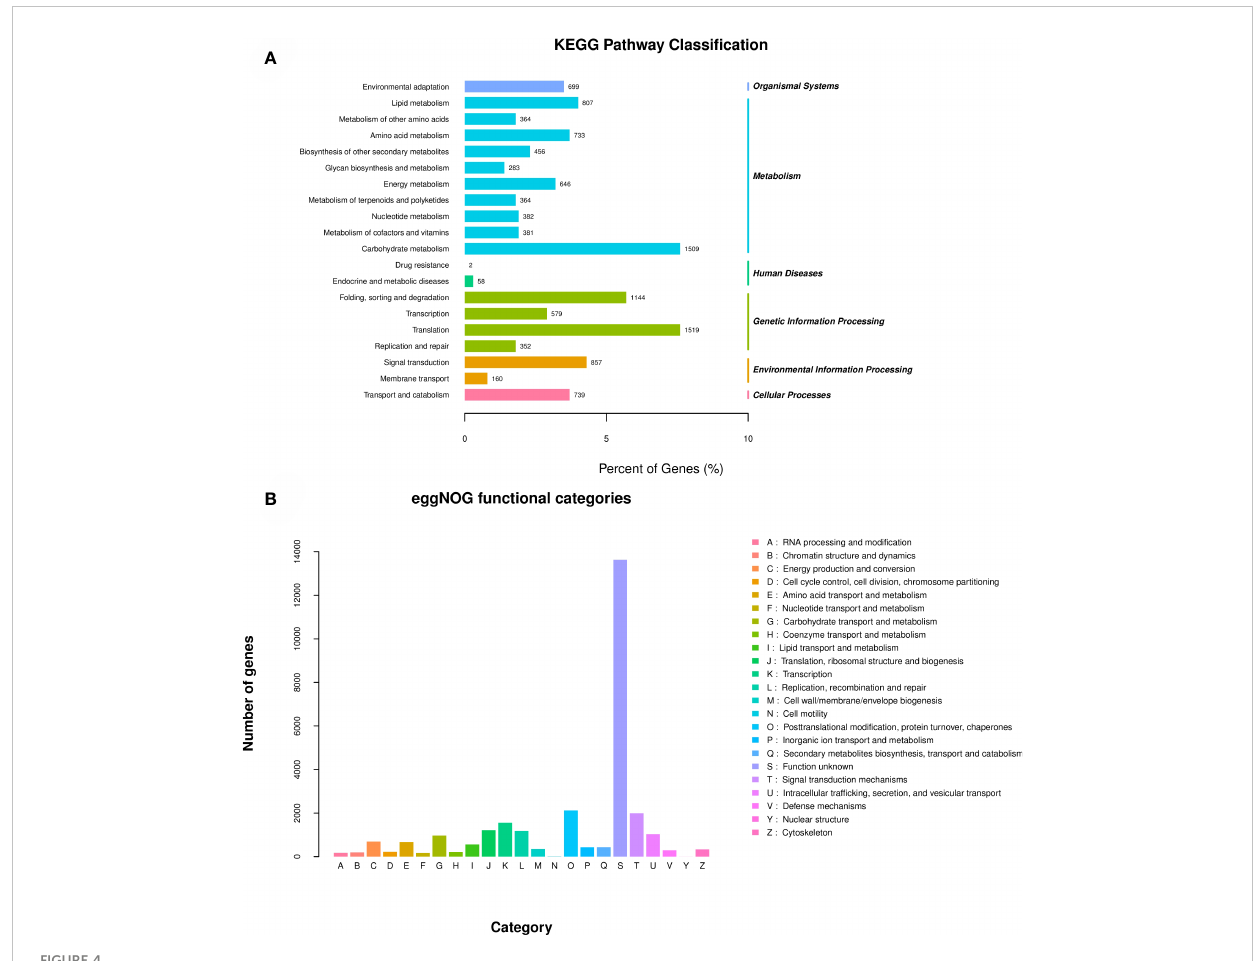
FIGURE 4 Results of the eggNOG function annotation (A) and the KEGG function annotation (B)